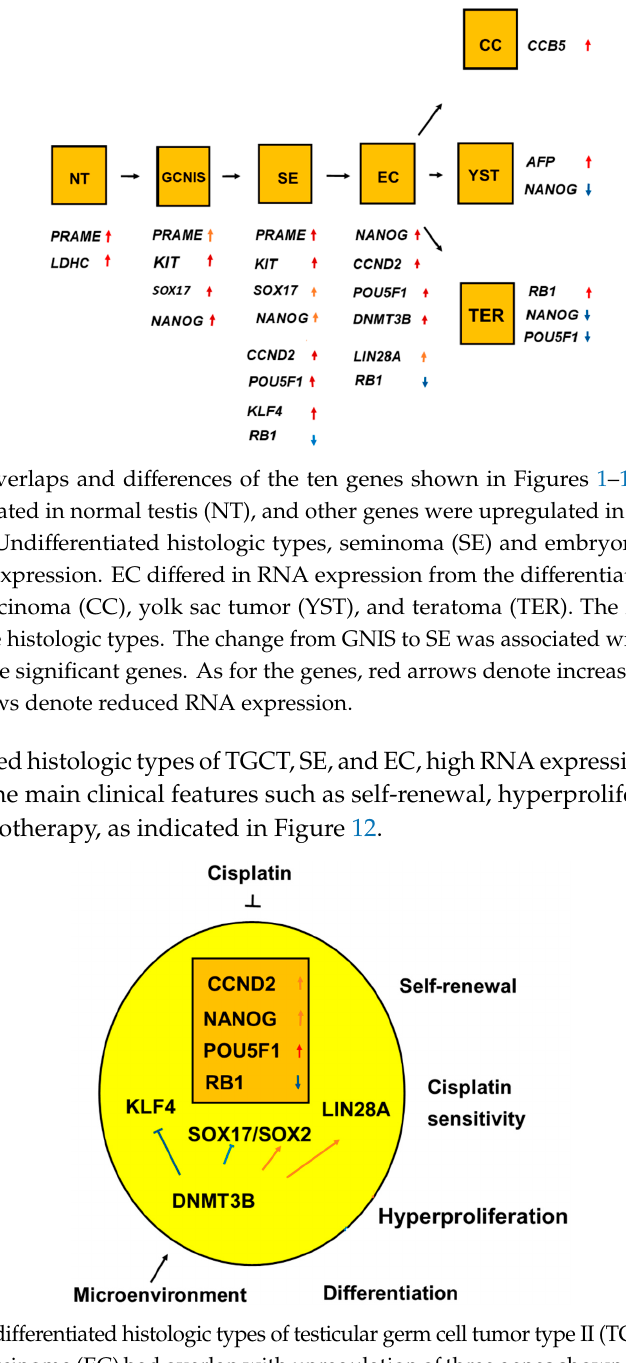
Figure 12. The undifferentiated histologic types of testicular germ cell tumor type II (TGCT), seminoma (SE), and embryonal carcinoma (EC) had overlap with upregulation of three genes shown with red arrows and downregulation of one gene shown with a blue arrow in the orange box. Microenvironmental factors can upregulate DNMT3B that blocks SOX17 and KLF4 and upregulates SOX2 and LIN28A , genetic changes associated with the histologic transition from a seminomatous cell type to an embryonal carcinoma cell type. Significant genes are associated with the main features of the malignant undi ff erentiated germ cells such as self-renewal, hyperproliferation, and sensitivity to platin-based chemotherapy. As for the genes, red arrows denote increased RNA expressions or a stimulus of genes and the blue arrows denote reduced RNA expression or an inhibition of